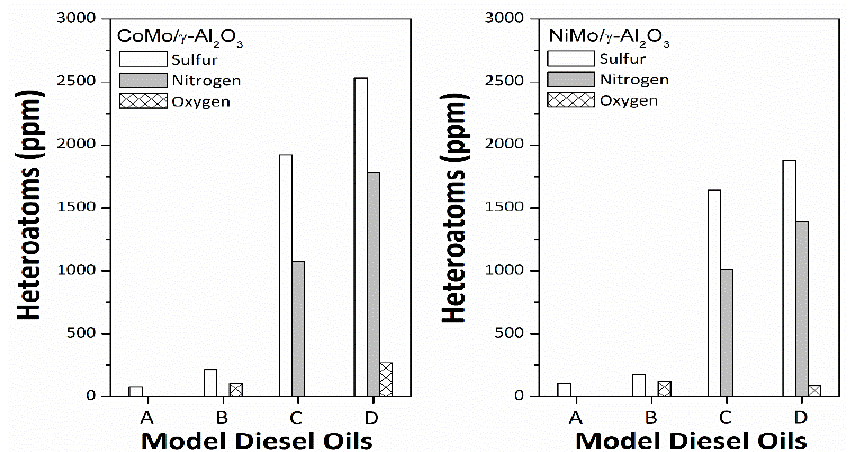
Figure 5. The activity of mesoporous sulfide catalysts to simultaneously remove heteroatoms from the model diesel oils A–D at 330 ◦ C and 1 h under a pressurized atmosphere of H 2 (5 MPa), where the model diesel oils were made by 70% of n-hexadecane and 30% of tetralin with addition of sulfur-, oxygen- and nitrogen-containing model molecules (please see Table S1, ESI).